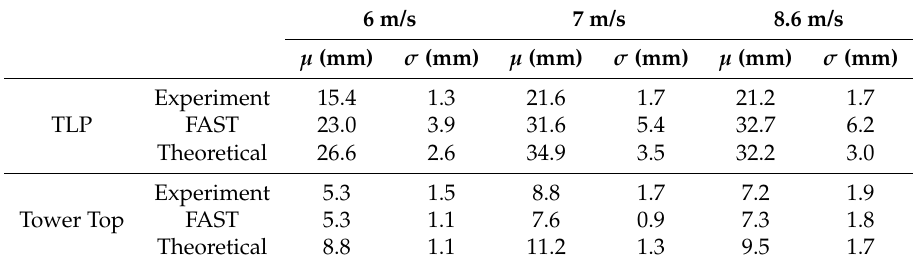
Table 6. The mean ( µ ) and standard deviation ( σ ) of the displacement of the TLP and tower top from the experimental data and simulation in FAST and by the theoretical model at three applied mean wind speeds: 6 m/s, 7 m/sand 8.6 m/s. 6 m/s 7 m/s 8.6 m/s µ (mm) σ (mm) µ (mm) σ (mm) µ (mm) σ